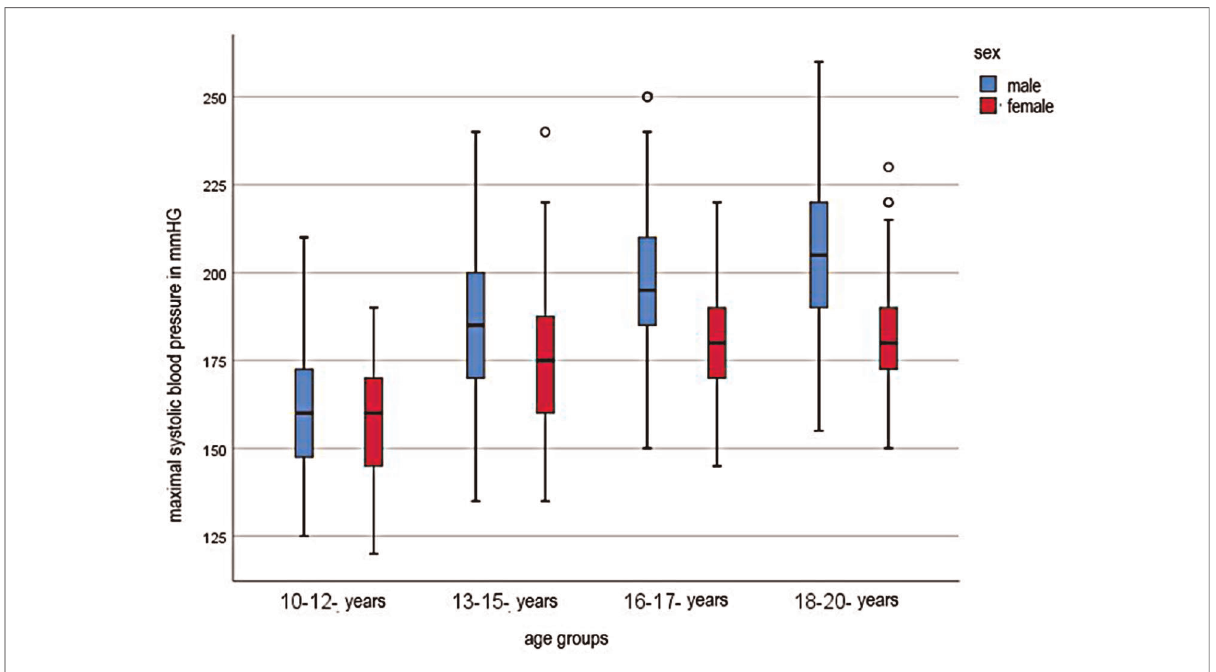
FIGURE 1 Systolic maximal blood pressure for age